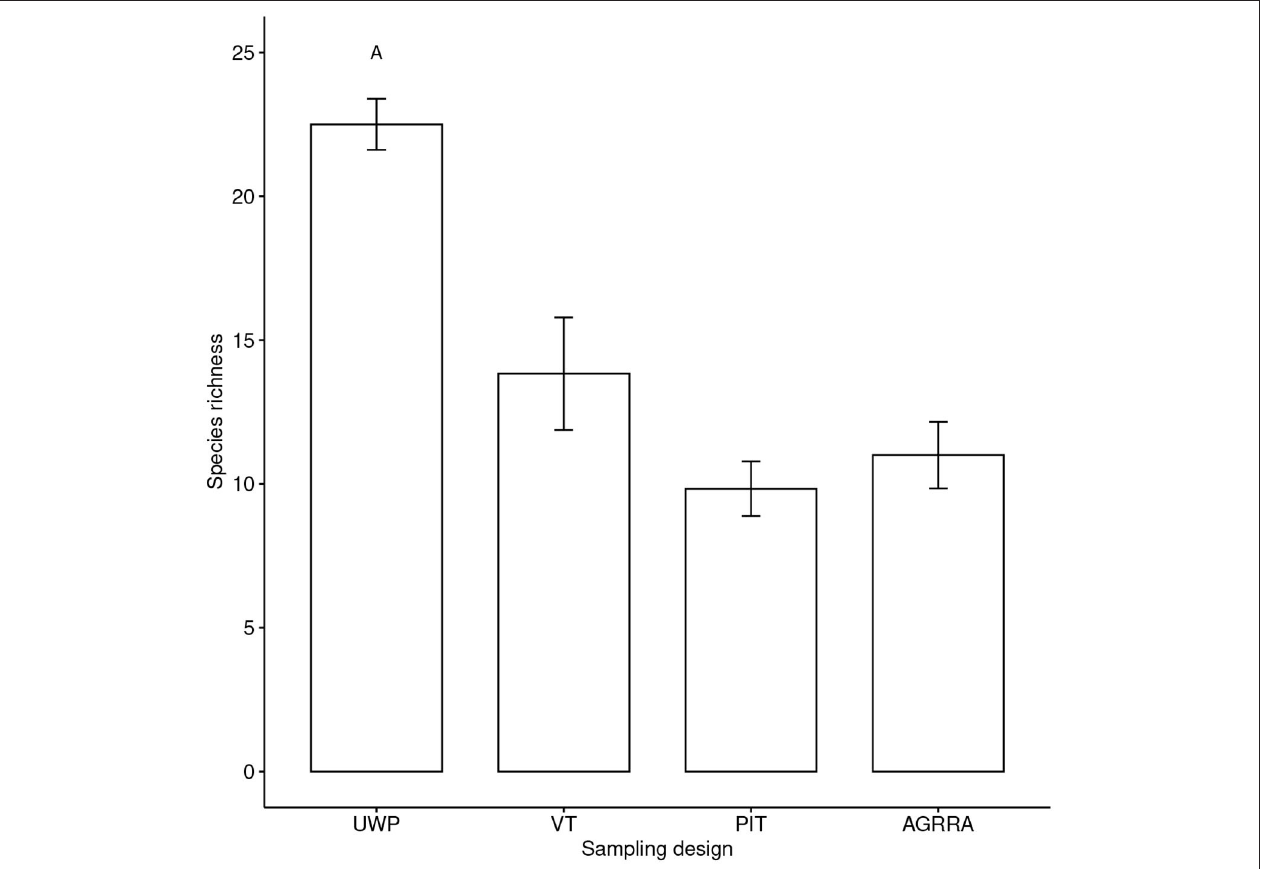
FIGURE 7 | Average number of species ( ± SD) obtained with each sampling design. Underwater digital photogrammetry (UWP), videotransect (VT), point intercept transect (PIT), and Atlantic and Gulf Rapid Reef Assessment (AGRRA). UWP recorded the highest number of species. The letter indicates a significant difference ( p <